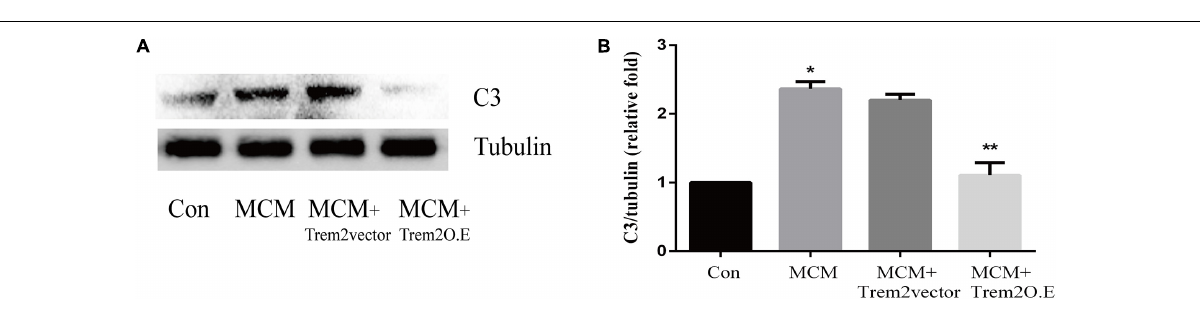
FIGURE 10 | A1 astrocytic marker C3 protein expressions were tested in MCM or triggering receptor expressed on myeloid cells 2 (TREM2) (vector or overexpression) + MCM after incubation for 24 h. (A) Western blot of C3 protein; tubulin was used as the internal loading control. (B) Quantitative analysis of the C3 protein expression. The data are expressed as means ± standard deviation (SD) from three independent experiments. * p < 0.05 versus control, ** p < 0.05 versus MCM. The data are expressed as means ± SD from three independent